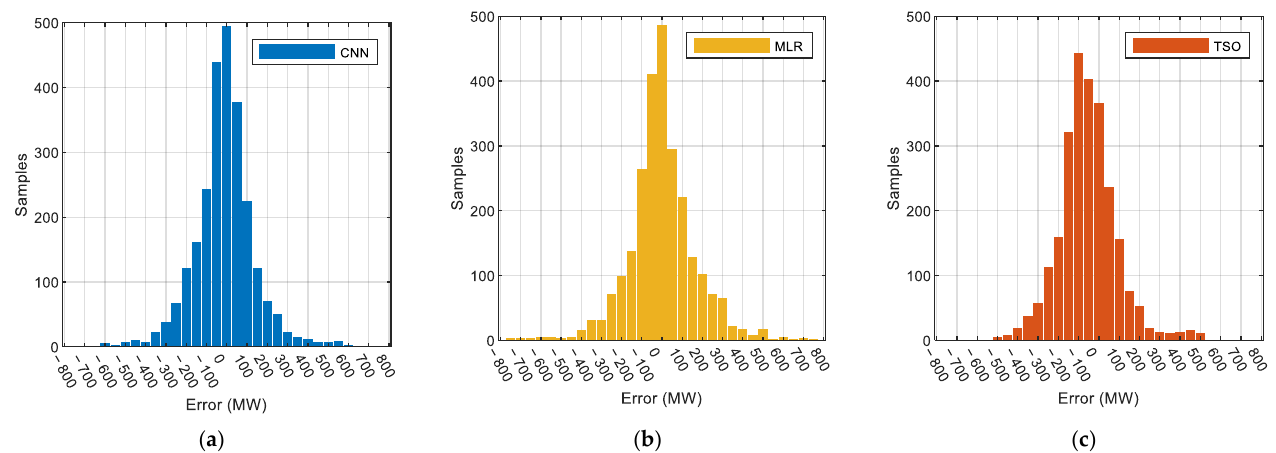
Figure 7. Comparison of error distributions for: ( a ) Convolutional Neural Network (CNN); ( b ) Multiple Linear Regression (MLR); ( c ) Transmission System Operator (TSO).